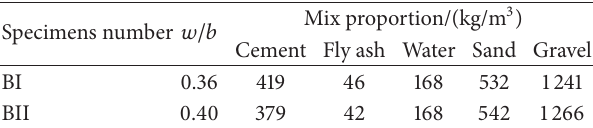
Table 1: Mix proportion of concrete.